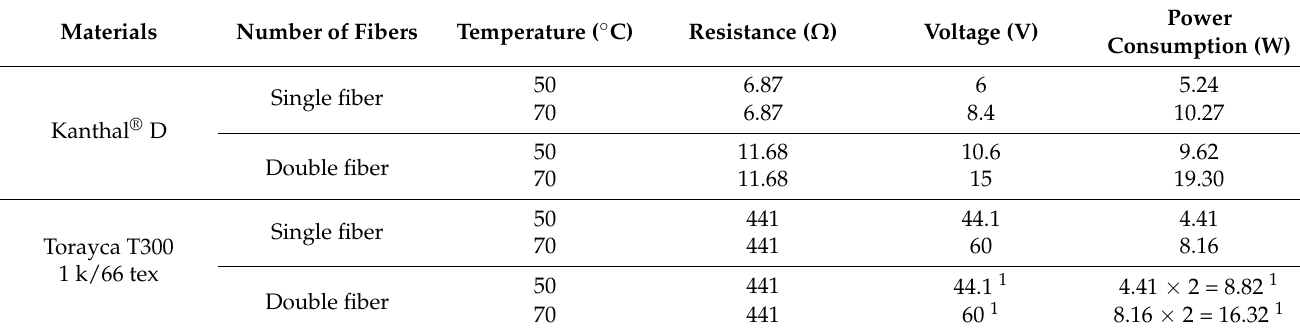
Table 4. Power consumption of Kanthal and carbon fiber specimens cured via Joule heating.